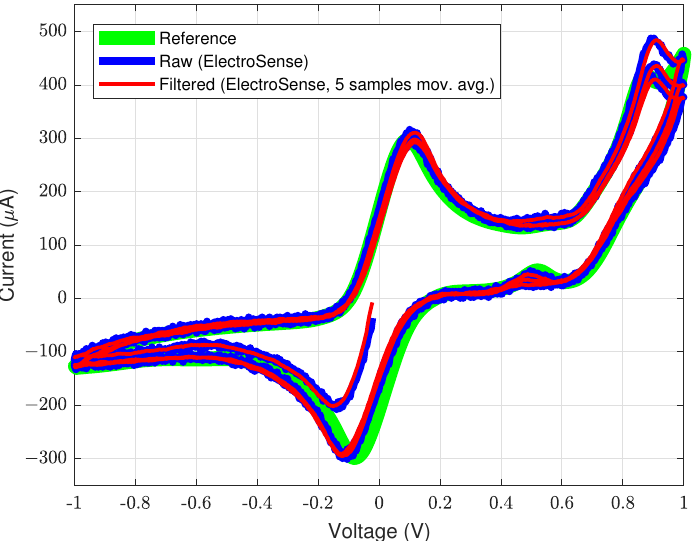
Figure 8. Reference voltammogram obtained from commercial instrument (green), raw voltammo- gram obtained from ElectroSense (blue), and filtered voltammogram from ElectroSense (red) obtained through a moving average filtering of the raw curve with a window of 5 samples.